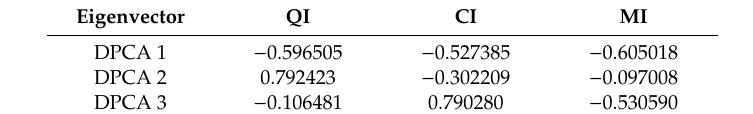
Table 4. Eigenvector matrix of the ASTER TIR band ratio indices derived from the DPCA for the selected subset covering the Cu-Au mineralization belt and surrounding